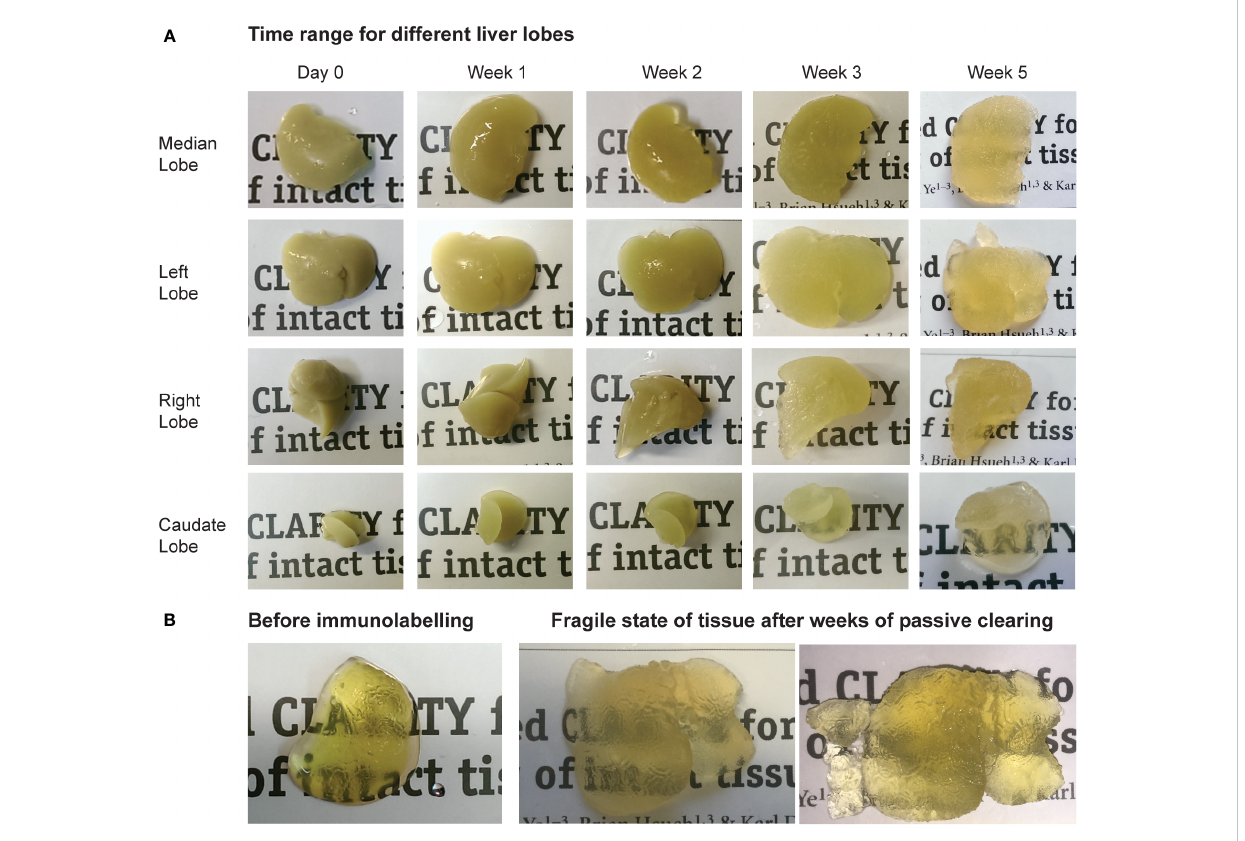
FIGURE 2 Tissue clearing using hydrogel-based CLARITY method. (A) Time range showing the passive clearing process for different liver lobes. (B) Before immunolabeling, adequate transparency of tissue was reached for the liver lobes. As passive clearing required several weeks of the tissues being in contact with strong detergent solutions before they were rendered adequately transparent for imaging, the samples became extremely fragile and would easily fragment during experimental